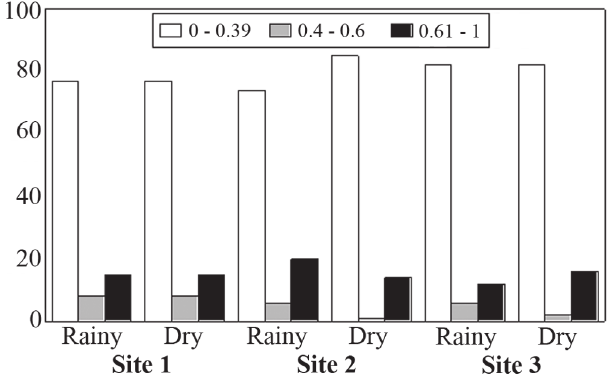
Fig. 3. Overlap values for the fish fauna of Itiz stream, Ivaí River basin, Paraná State, Brazil, using Pianka’s index, for each sampling site in the rainy and dry hydrological periods. Diet overlap was considered low (0-0.39), intermediate (0.4- 0.6) or high (0.61-1).